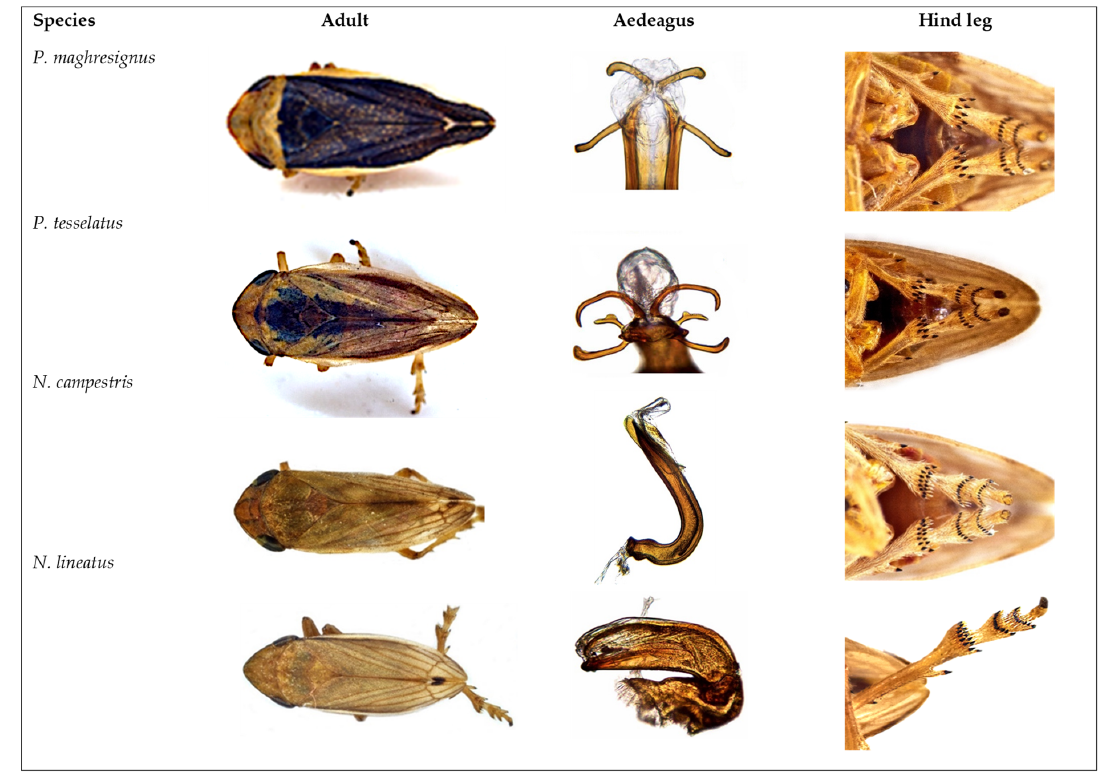
Figure 2. Philaenus and Neophilaenus species identification features (Adults, aedeagus and hind